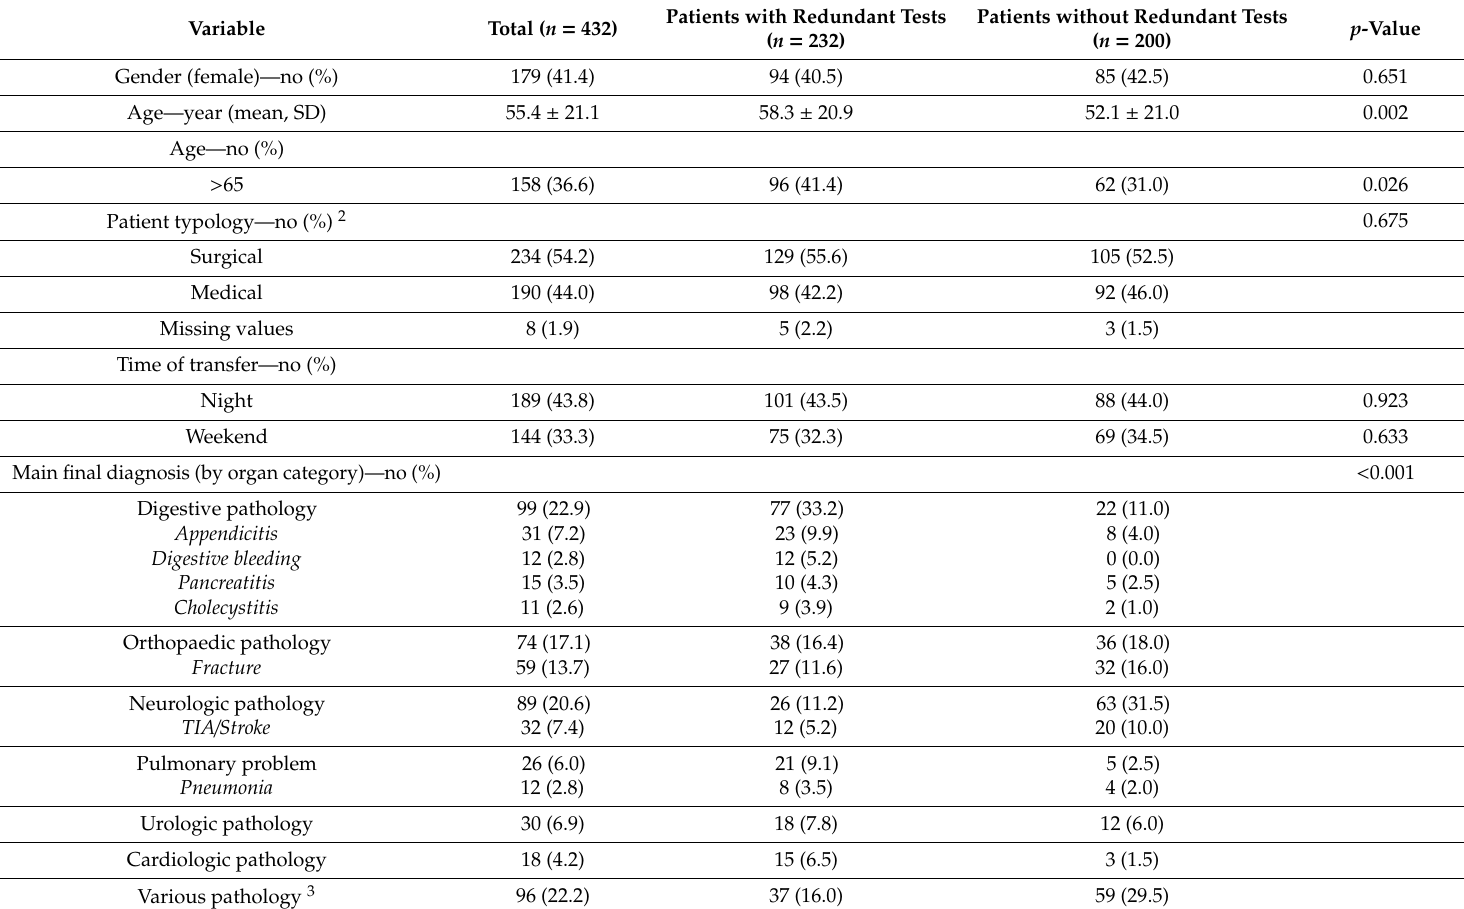
Table 1. Patients’ characteristics 1